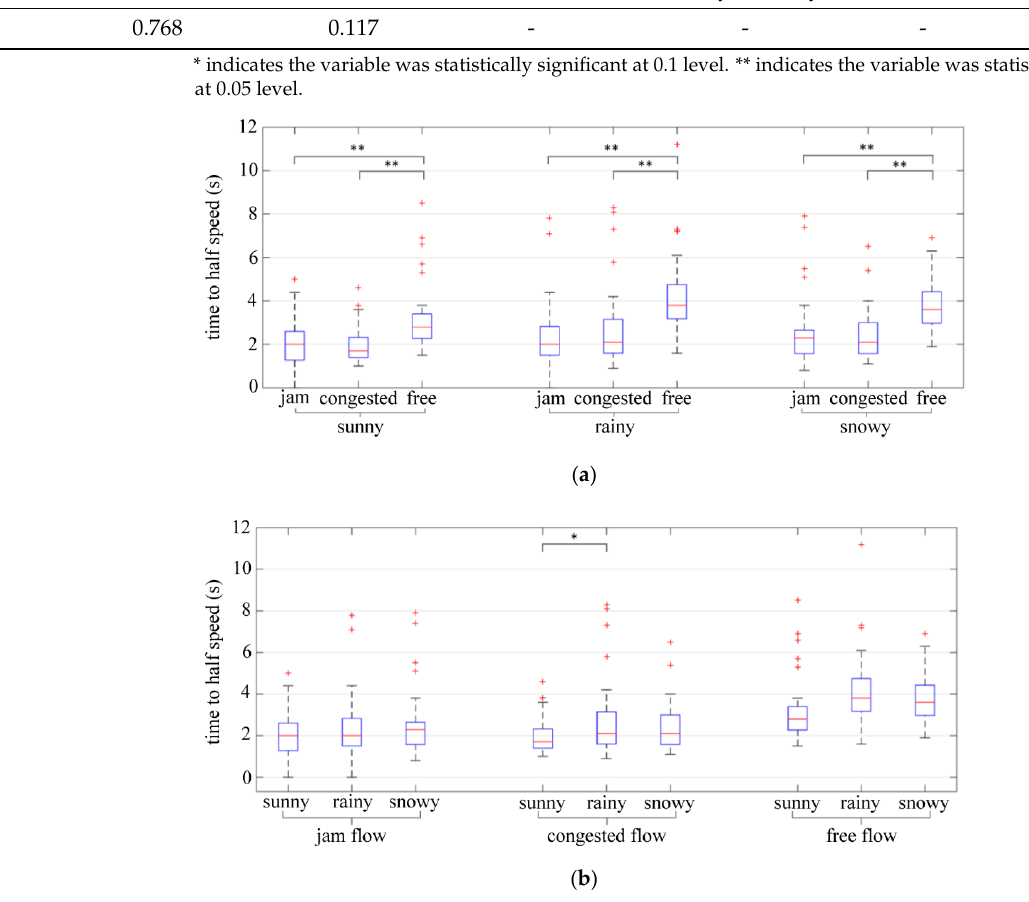
Figure 16. “Time to half speed”. ( a ) “Time to half speed” in different traffic flow conditions. ( b ) “Time to half speed” in different weather conditions. ** indicates the variable was statistically significant at 0.05 level. + indicates outlier. * indicates the variable was statistically significant at 0.1 level.